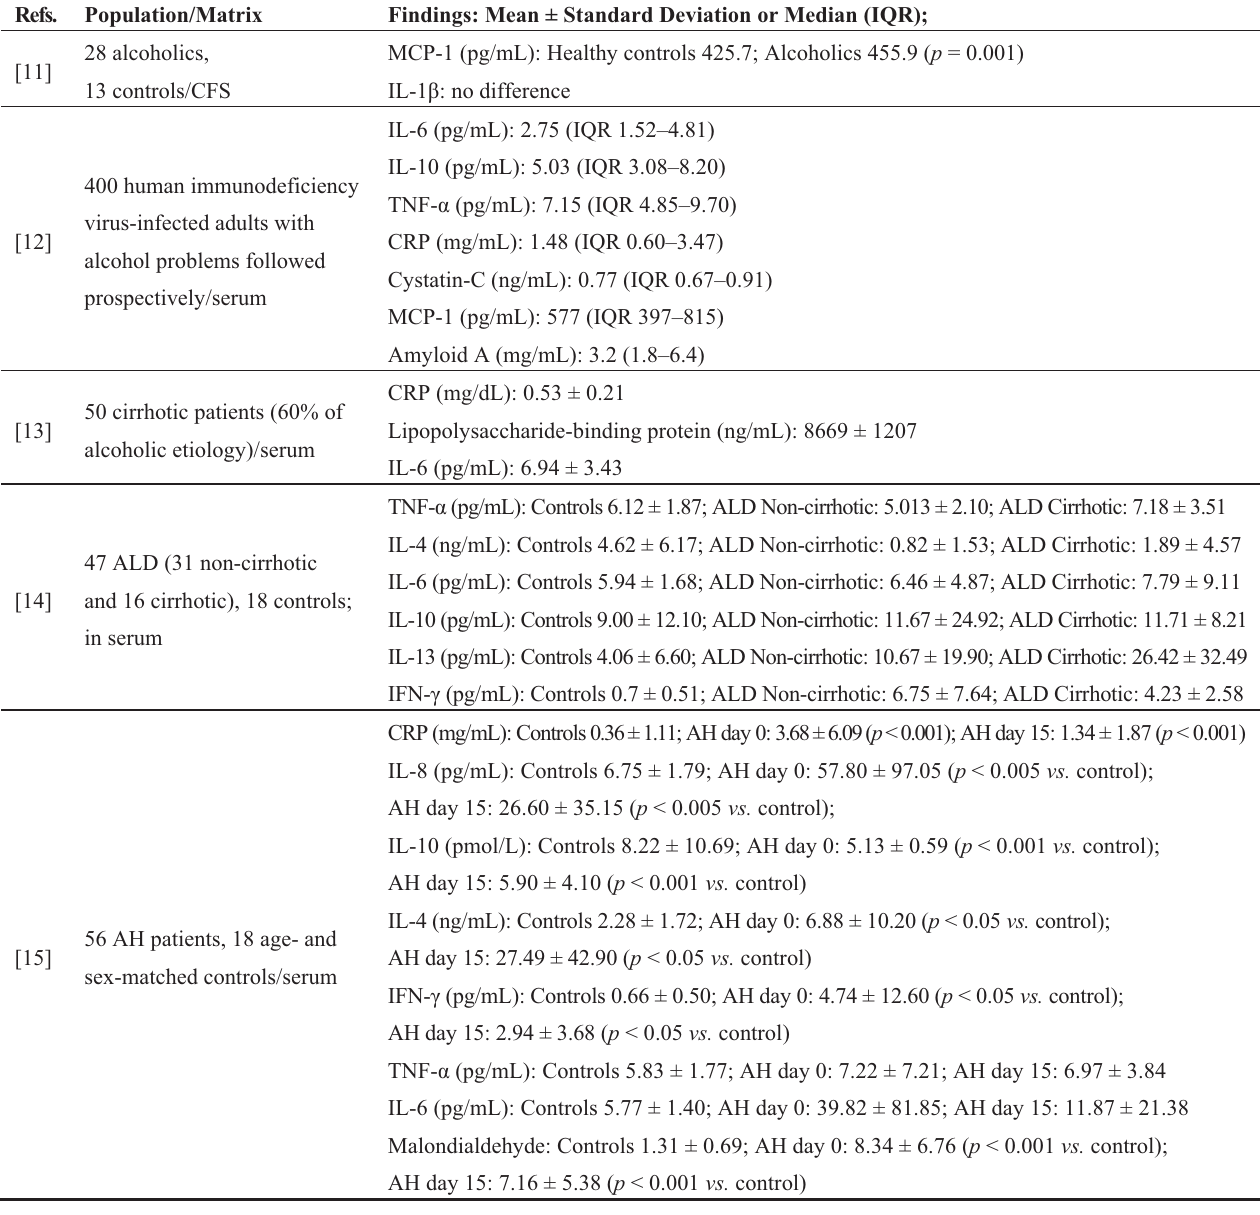
Table 1. Cytokine and pro-inflammatory markers levels in alcoholic liver disease patients. AH: alcoholic hepatitis; ALD: alcoholic liver disease; CSF: cerebrospinal fluid; hsCRP: high-sensitivity C-reactive protein; IFN: interferon; IL: interleukin; IQR: interquartile range; MCP: monocyte chemoattractant protein; sIL-2R: soluble IL-2 receptor; sTNF-R55: soluble tumor necrosis factor receptor 55; TGF: transforming growth factor; TNF: tumor necrosis factor; VEGF: vascular endothelial